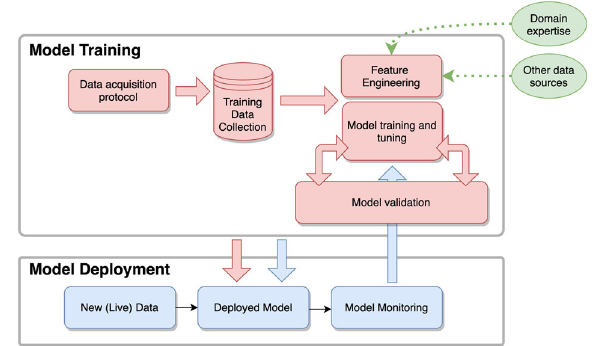
Fig. 1 A high-level block diagram for clinical AI model develop- ment. During model training, algorithm designers collect a large training dataset consisting of data from different modalities, each acquired according to some prede fi ned protocol. These data are used to engineer a feature set and train a model to automate a clinical decision of interest. The fi nal model and feature set are selected using a cross-validation procedure on a held-out test set. After model deployment, real-world model performance can be monitored and the original model can be iteratively updated and re-